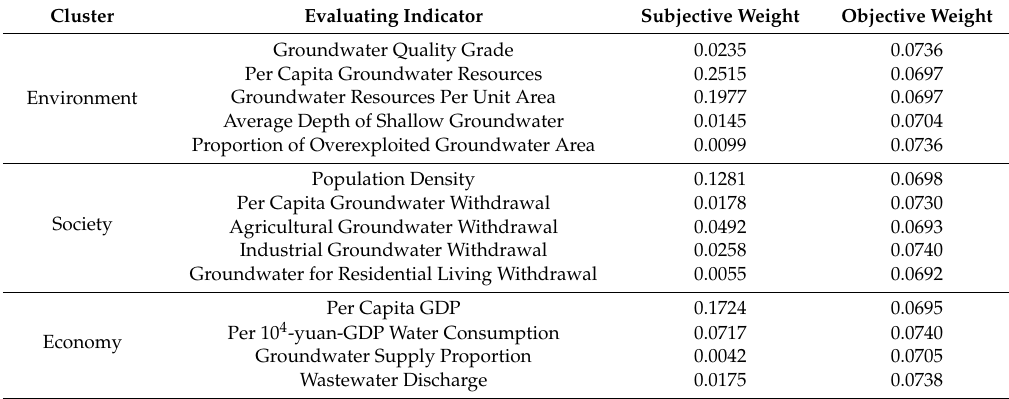
Table 5. Indicator weight of groundwater rights